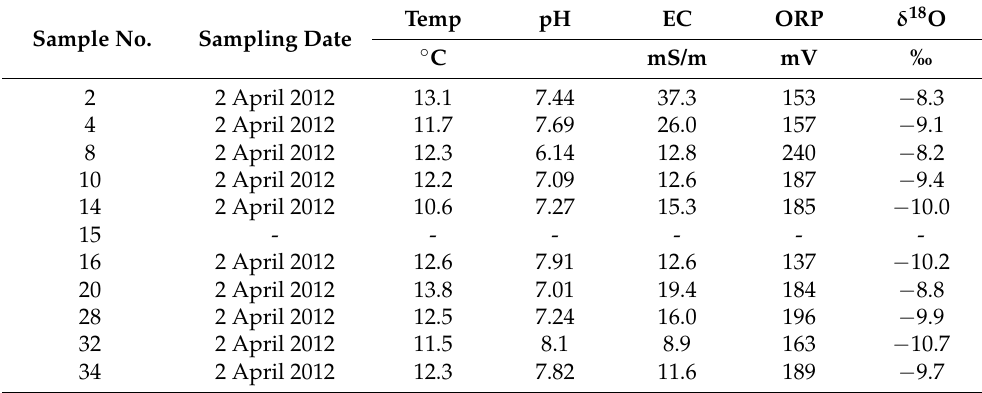
Table 2. Water temperature, pH, electric conductivity (EC), oxidation–reduction potential (ORP), and δ 18 O composition for groundwater samples in the Sho River alluvial fan on 2 April 2012.